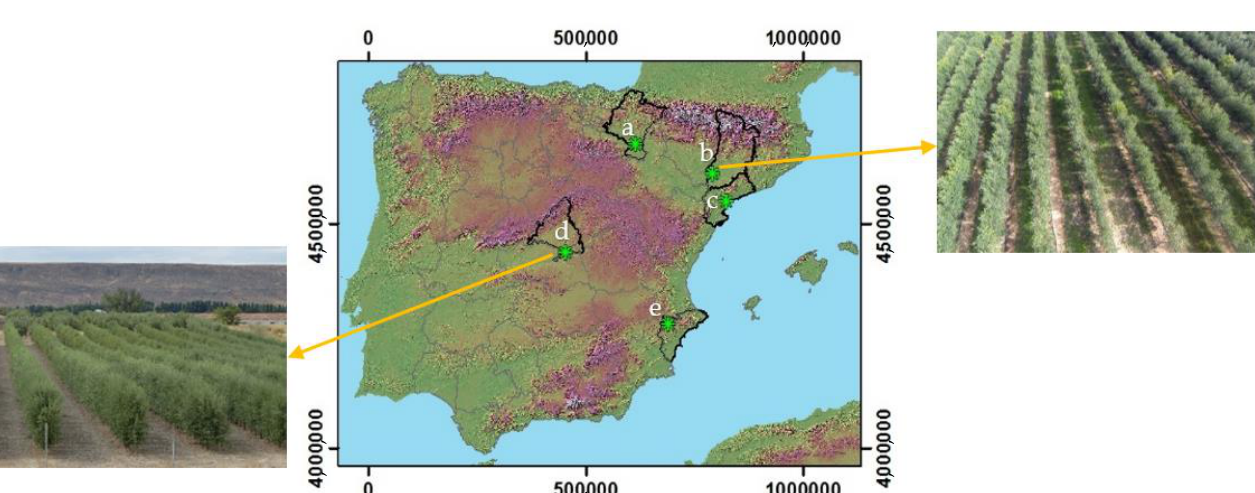
Table 1. Main agroclimatic characteristics of the 5 olive groves and irrigation quantities in each crop